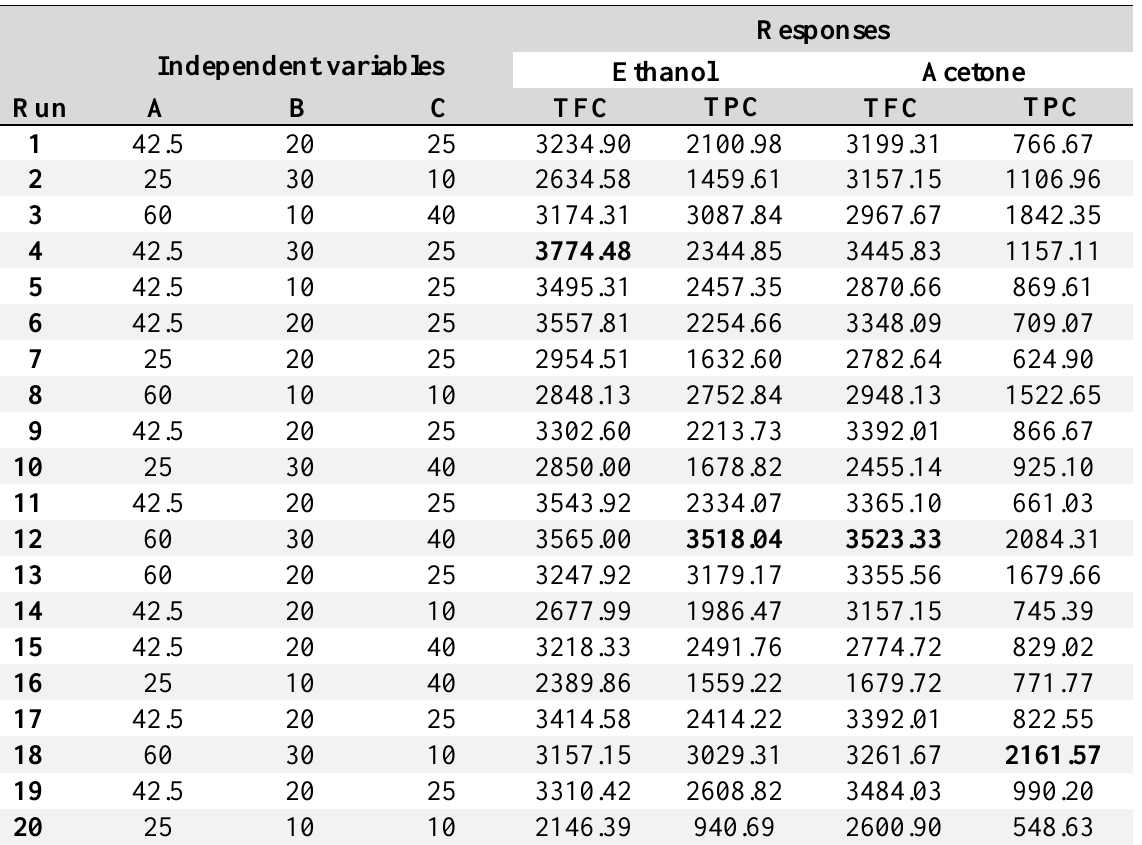
Table 2. The CCFC experimental design and response values for the optimization of extraction